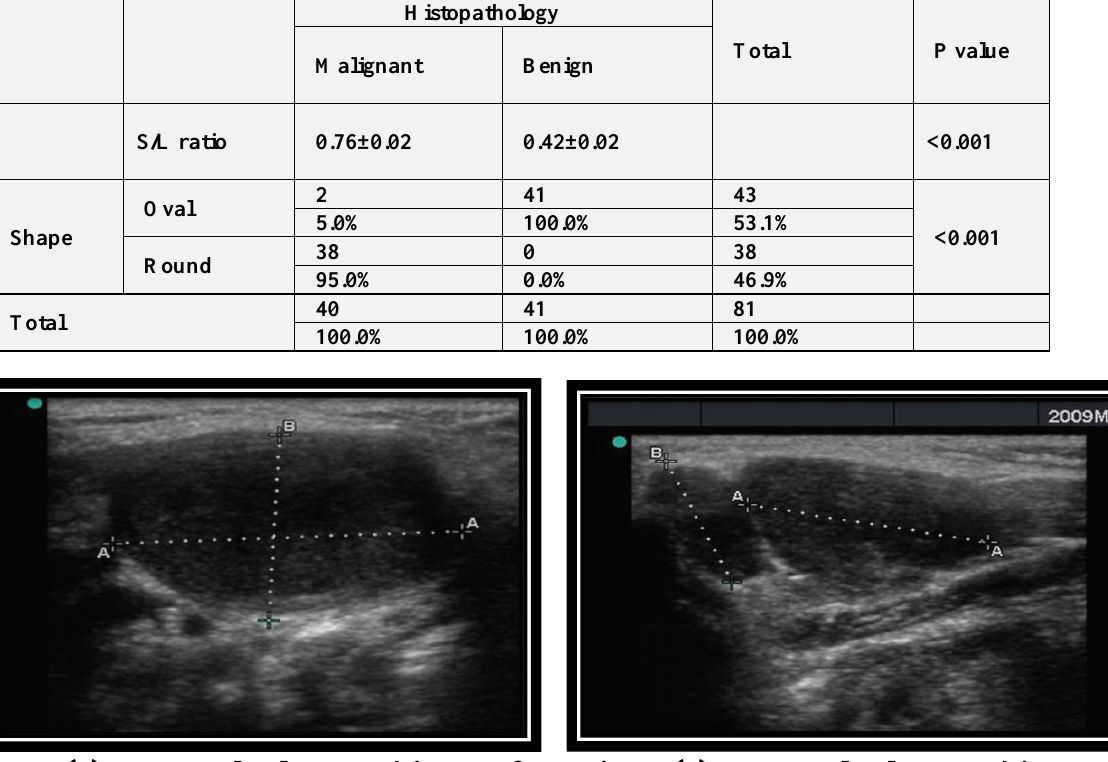
Table (8):- Association between shape of L.Ns and histopathological findings